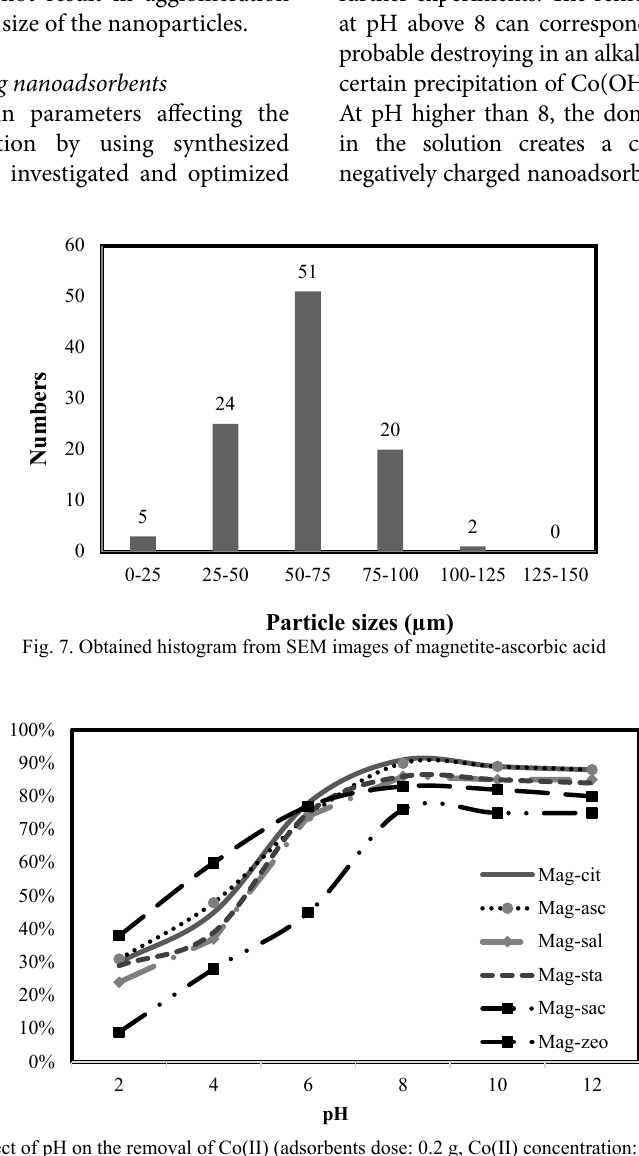
Fig. 8. Effect of pH on the removal of Co(II) (adsorbents dose: 0.2 g, Co(II) concentration: 25